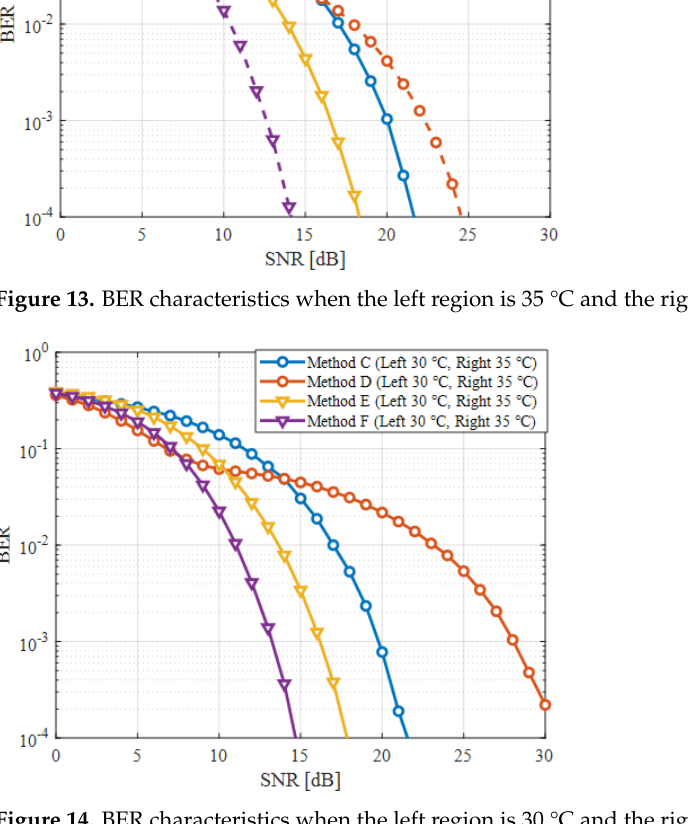
Figure 14. BER characteristics when the left region is 30 °C and the right region is 35